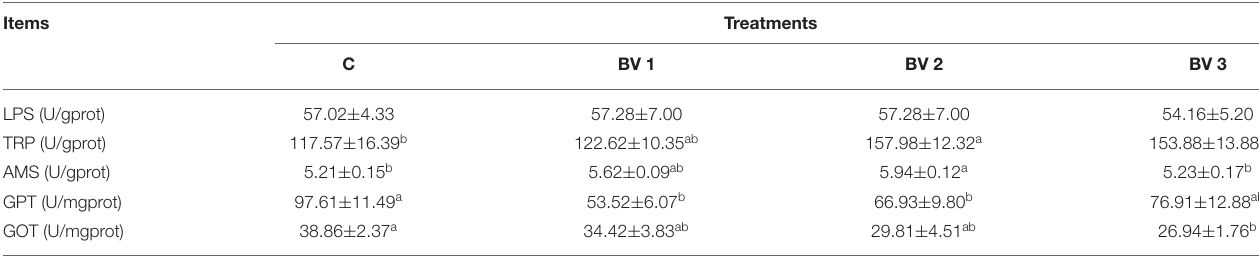
TABLE 3 | Digestive enzyme activities in the hepatopancreas of L. vannamei fed diets containing 0 CFU/g (C), 10 5 CFU/g (BV1), 10 7 CFU/g (BV2), 10 9 CFU/g (BV3) B. velezensis for 6